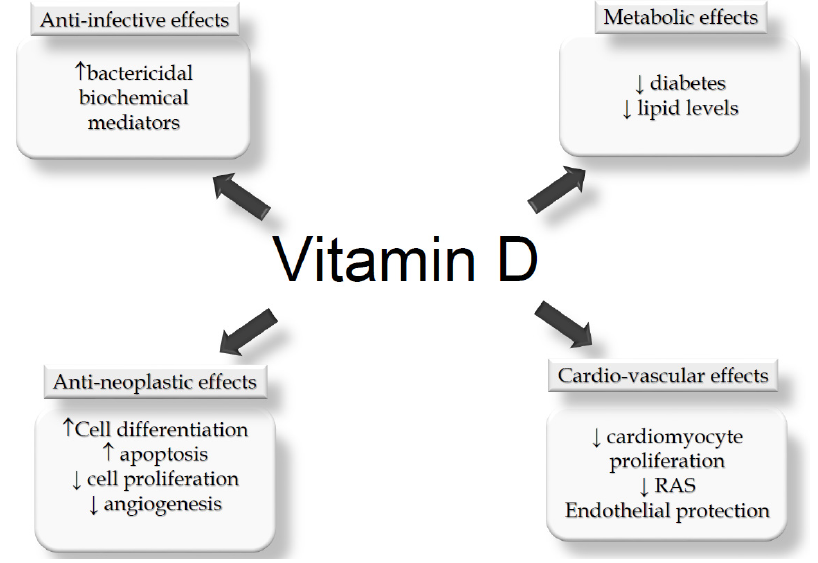
Figure 1. Suggested “non ‐ mineral and bone metabolism (MBM) related” effects of native vitamin D which could play a beneficial role on the main clinical complications which occur in kidney transplant (KTx) patients. RAS = renin angiotensin system.